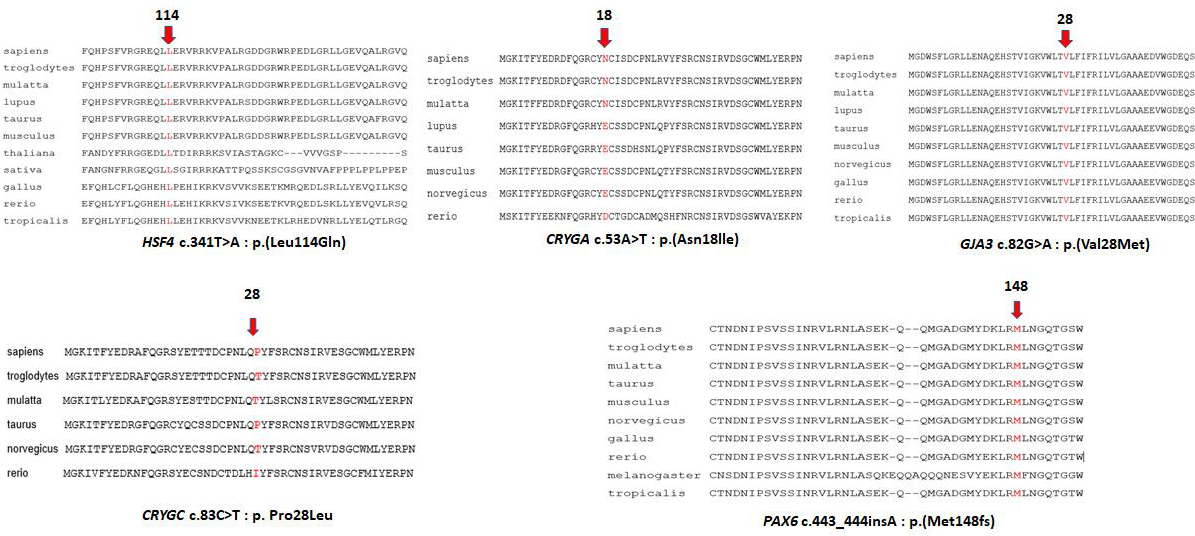
Figure 3. Multiple sequence alignments from different species of regions surrounding cataract mutations. Arrows and the amino acids in red indicate the position of the mutation.